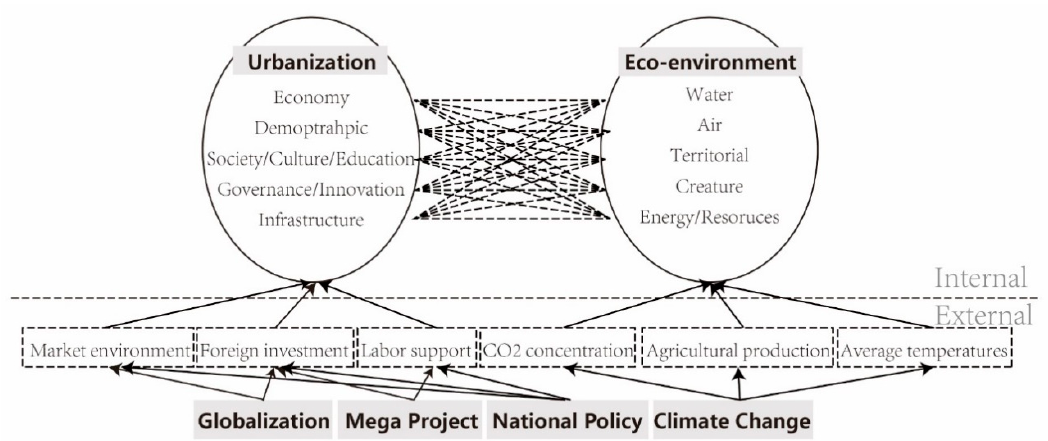
Figure 6. Internal correlation and external inflows of Urbanization and Eco-environment subsystems. Source: Edited according to Wang et al. [74].